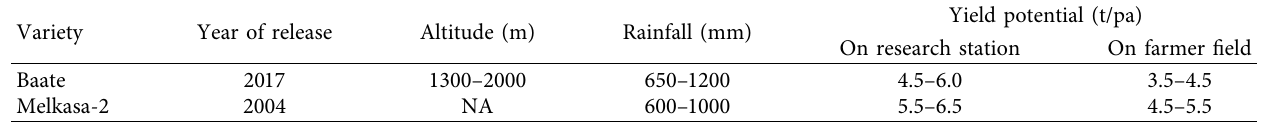
Table 2: Experimental materials used in the